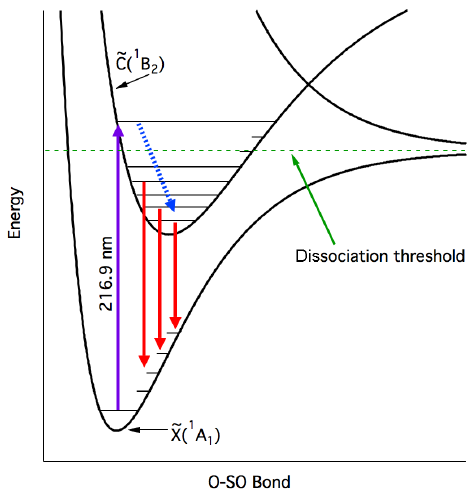
Figure 2. Schematic of the relevant SO 2 electronic structure and LIF process. Excitation from the ground state, e X, to above the dis- sociation threshold in the e C state at 216.9nm (purple line) leads to predissociation in the majority of SO 2 molecules. A small frac- tion undergo internal vibrational relaxation (dashed blue arrow) fol- lowed by red-shifted fluorescence (red